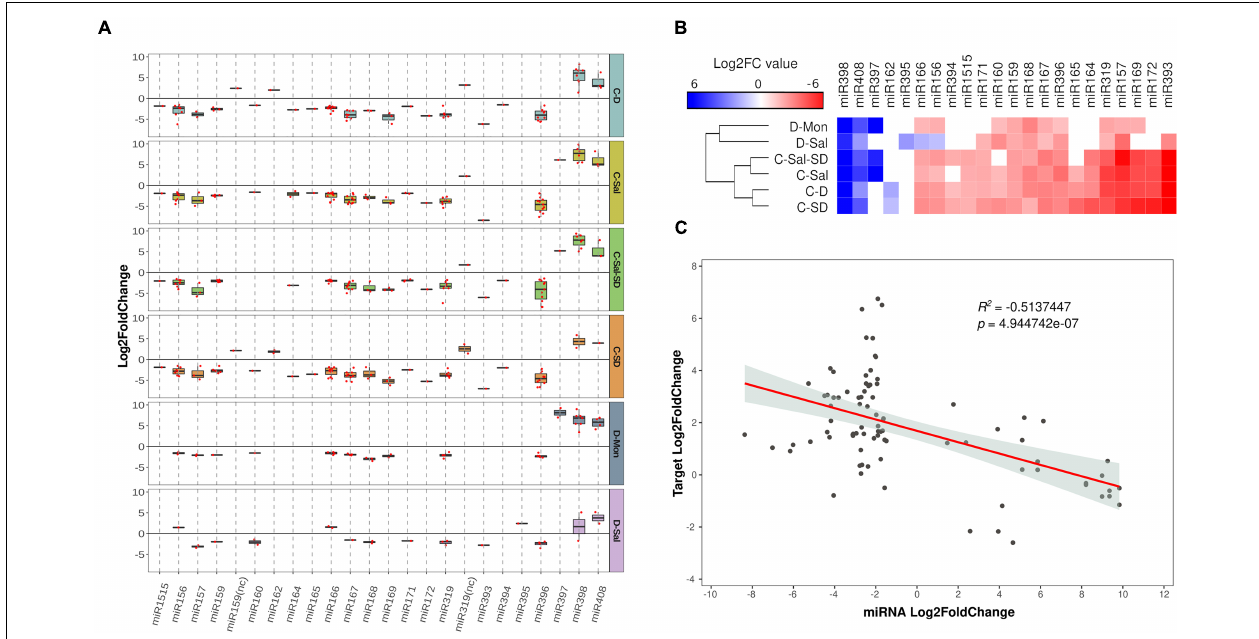
FIGURE 2 | General description of stress-responsive miRNA families. (A) Boxplot analysis showing the general expression value observed for each miRNA family member. To determine the general sense of the expression for each miRNA family, we employed the median value of expression (represented by internal box line) estimated by boxplot analysis of all family-related sequences. The differential expression values represented in the figure correspond to the log 2 FC obtained using edgeR. (B) Heatmap of 22 miRNAs differentially expressed in melon in response to combined stress. The differential expression values represented correspond to the median of the log 2 FC values obtained using edgeR for each miRNA family. (C) A scatter plot showing the significant negative correlation (estimated by Pearson correlation coefficient) between the expression levels of 16 selected stress-responsive miRNAs with differential accumulation determined by sequencing and the accumulation of their targets in the corresponding stress conditions, estimated by